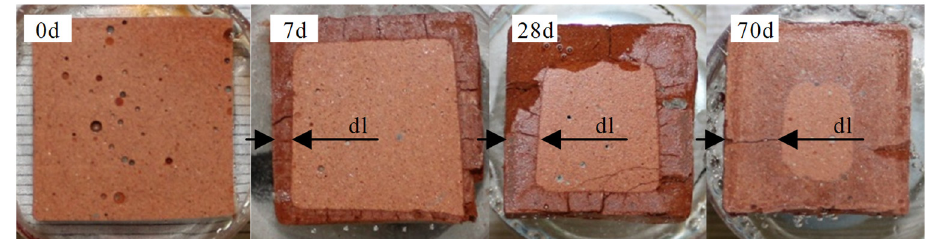
Figure 9. Epoxy embedded samples of geopolymers MK54 for measuring the eroded layer (el) and the deteriorated layer (dl), before (0 d), and after sulfuric acid exposure (7 d, 28 d, and 70 d).